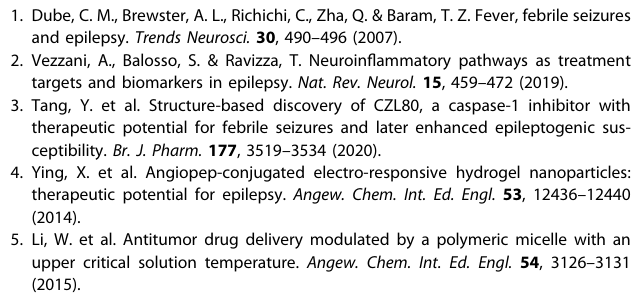
(Fig. 1r). Importantly, anticonvulsive ef fi cacy of CZL80-loaded micelles was completely lost in FS model with Casp1 − / − mice (Fig. 1s, t), suggesting that caspase-1 activity is required for the anticonvulsive effect of CZL80-loaded micelles. In addition, CZL80- loaded micelles at 10-fold effective concentration did not affect in vitro cell viability (Fig. S7), biochemistry index in in vivo routine blood test (Fig. 1u – x) and the number of neuron and microglia in the cerebral cortex of mice (Fig. S8), suggesting no acute side effect. In conclusion, we loaded the anti-in fl ammatory small-molecular caspase-1 inhibitor CZL80 to thermo-sensitive micelles, which permitted drug release upon hyperthermia stimulus and extended